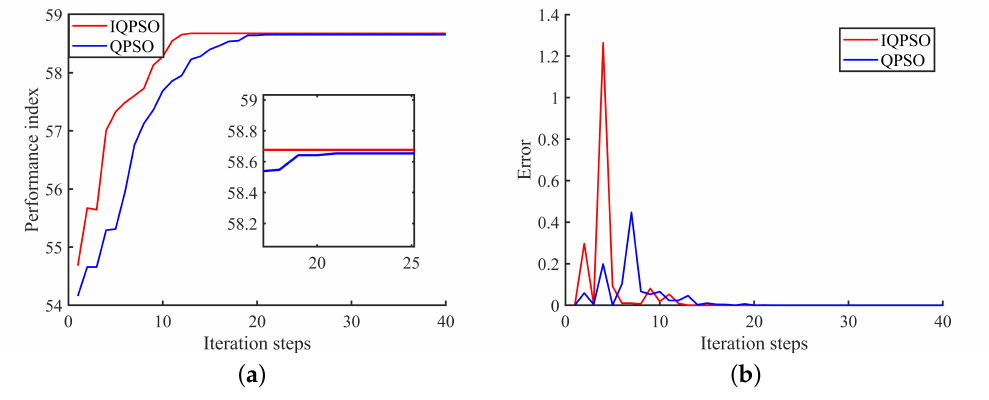
Figure 2. Iterative process of the IQPSO. ( a ) Performance index. ( b ) Error.